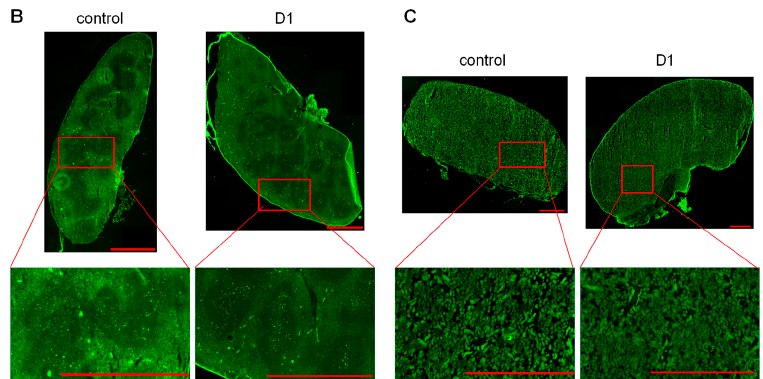
Figure 2. Fluorescence images of entire organs after an intravenous (IV) injection of the green fluorescent ABP-Julolidine dendrimer. Control mice have been IV injected with phosphate buffer saline (PBS). ( A ) Liver at days one and 10. ( B ) Spleen at day one. ( C ) Kidneys at day one. Red bars and white bars (for the zoom on the liver) represent 1 and 0.1 mm, respectively. Images are representative of one mice out of six.